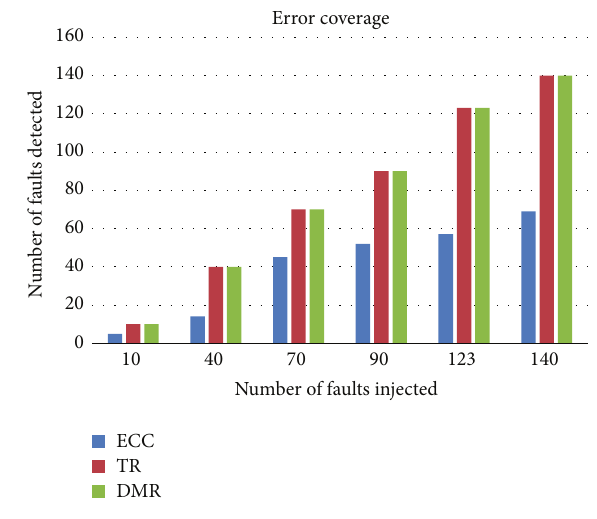
Figure 8: 4-bit injection and detection.